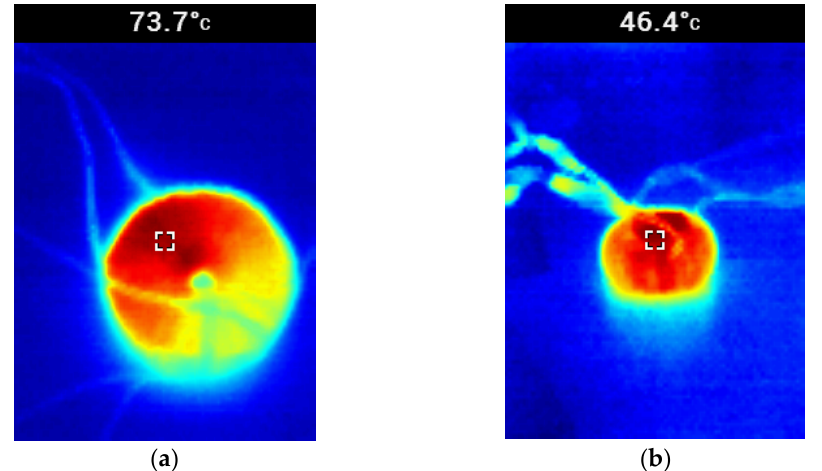
Figure 16. Thermography of the MFT-DAB lab prototype: ( a ) ferrite, ( b ) Nanocrystalline alloys. Table 10. Input and output voltages and currents, and efficiency obtained at full load. Table 12. MFTs construction cost.